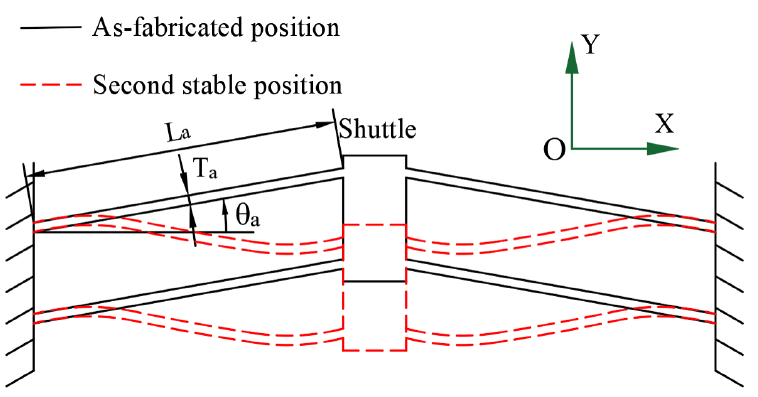
Figure 1. Fully compliant bistable mechanism.